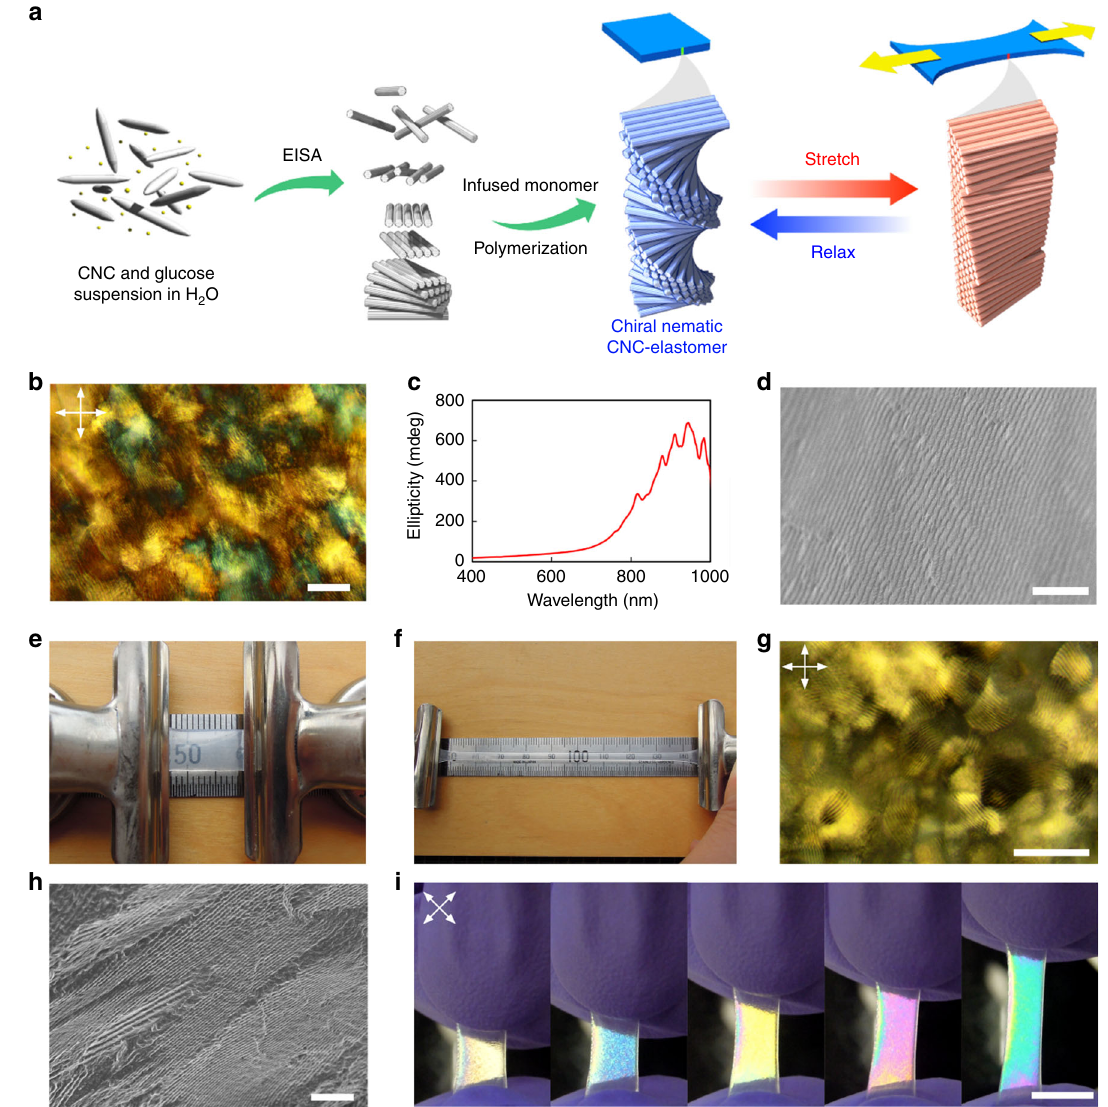
Fig. 1 Preparation of chiral nematic cellulose nanocrystal-elastomer (CNC-E). a Schematic illustration of the preparation of the chiral nematic organization of CNCs and preparation process of CNC-E. b Fingerprint texture of chiral nematic structure in glucose-containing chiral nematic CNC (G-CNC) observed on fi lm surface. Dark parts in fi ngerprints represent regions where incident linearly polarized light is converted to the other polarization states that do not transmit when the analyzer is arranged perpendicular to the polarizer. c Positive circular dichroism (CD) signal observed in G-CNC, con fi rming an overall left-handed chiral nematic arrangement. d Cross-section SEM image of G-CNC fi lm. e Photos of unstretched and f stretched CNC-E. The stretching direction is perpendicular to helicoidal axis of chiral nematic structure of CNCs. g Fingerprint texture observed in an unstretched fi lm of CNC-E when viewed by POM under crossed polarizers. h Cross-section SEM image of CNC-E fi lm. i Photographs of CNC-E stretching as viewed under crossed polarizers. The color of the composite changes from white to blue to yellow to pink to green upon stretching. (Arrows in image indicate polarization axes of both linear polarizer and analyzer.) Scale bars represent b 50 µ m, d 5 µ m, g 100 µ m, h 10 µ m, and i 1